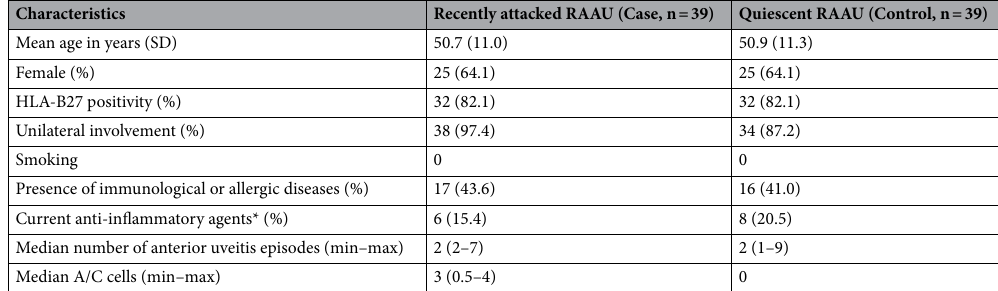
Table 1. Demographic characteristics of recurrent acute anterior uveitis at Siriraj Hospital, Bangkok, Thailand. RAAU recurrent acute anterior uveitis, SD standard deviation, HLA-B27 human leukocyte antigen-B27, A/C anterior chamber, min minimum, max maximum. *Systemic anti-inflammatory agents used in control of coexisting systemic autoimmune diseases.